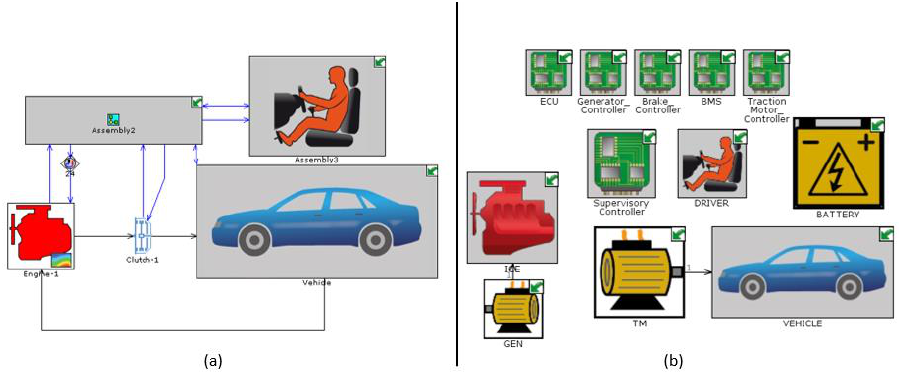
Figure 5. Simulation models built in GT-Power: ( a ) Conventional powertrain; ( b ) hybrid powertrain.